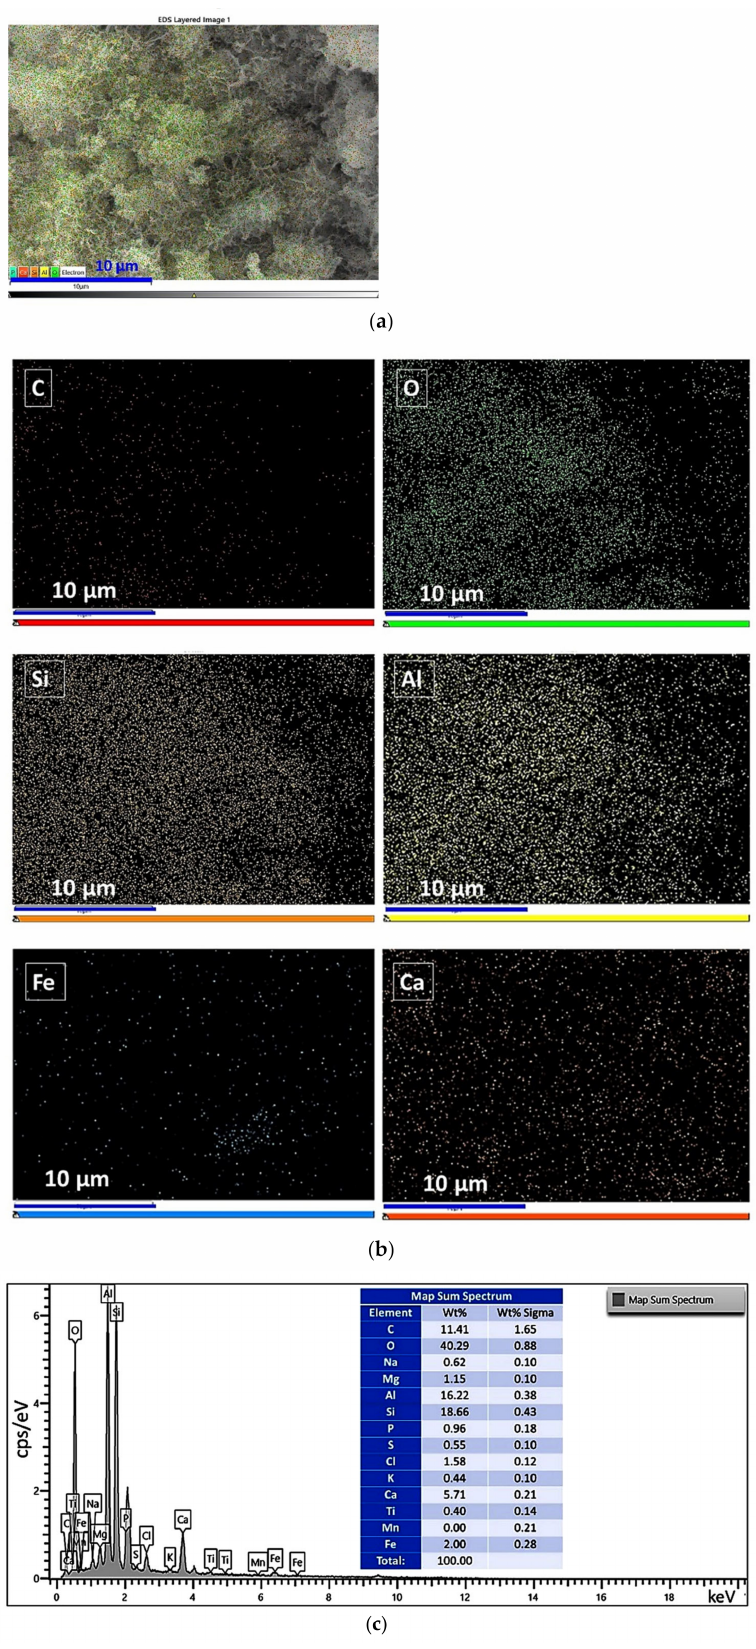
Figure 6. The EDS spectrum and elemental distribution of paste (G5) at 90 d by mapping technique: ( a ) EDS mapping, ( b ) elemental distribution, and ( c ) EDS